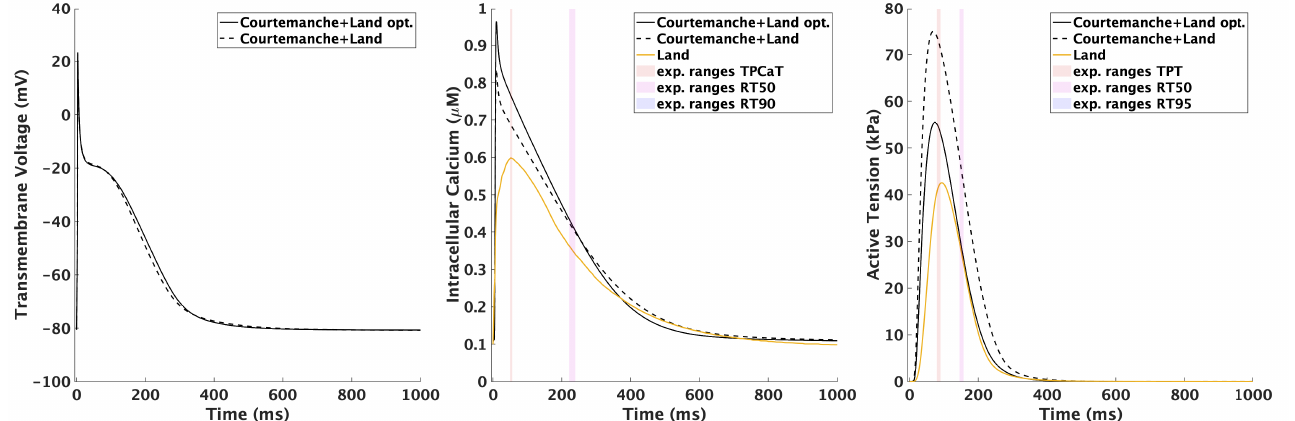
Figure 7. Action potential (left), CaT (center), and active tension (right) of the optimized (solid line) and the original (dashed line) atrial model with reference experimental values from literature [129]. TPCaT: time to peak of calcium transient; TPT: time to peak tension; RT50/90/95: relaxation times to 50/90/95% decay from peak calcium/tension. Only the last cycle is visualized.